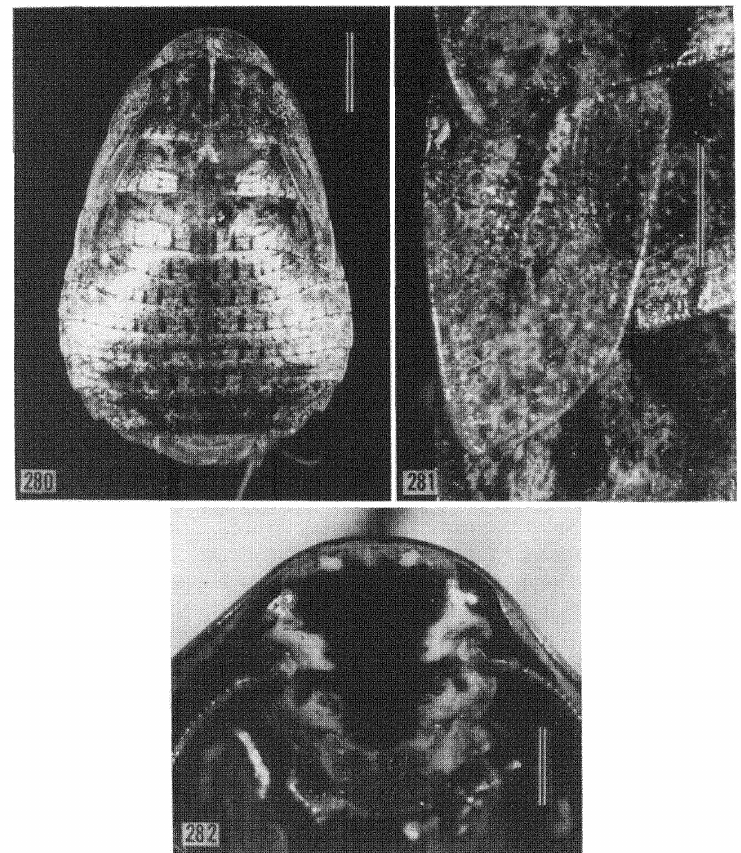
Figures 280-282. Calolamtra pernotabilis. Fig. 280 ram; Figs. 281-282